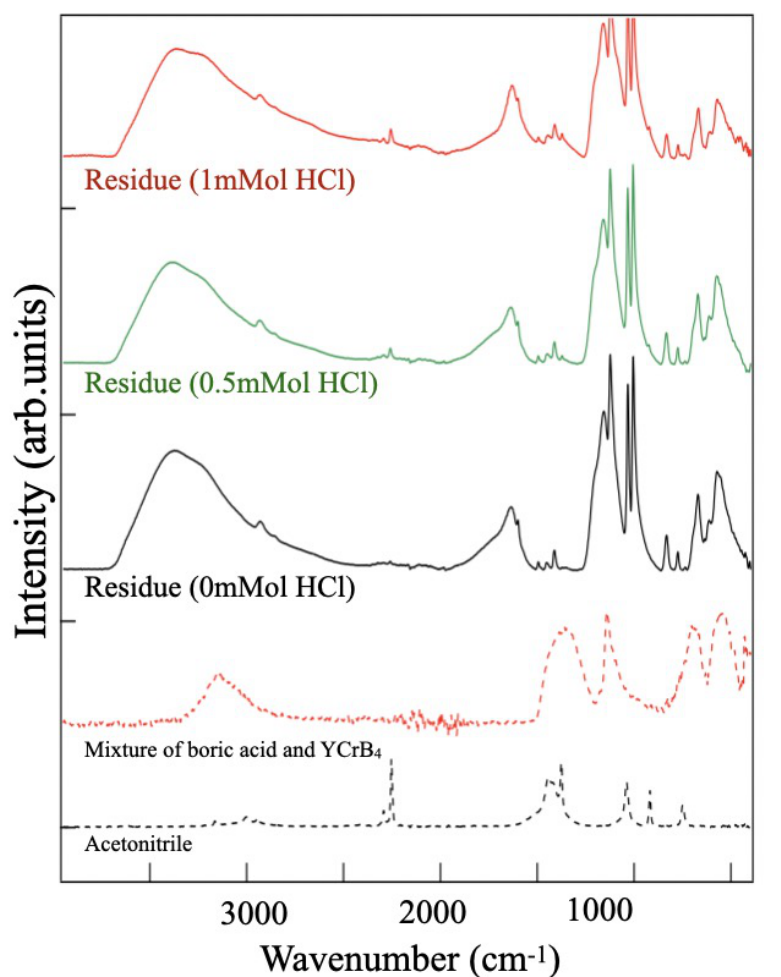
Figure 9. FT-IRAS spectra of the residue obtained from different amounts of HCl, taken after three days of reaction. Reference spectra of a mixture (boric acid and YCrB4) and the acetonitrile solvent are also